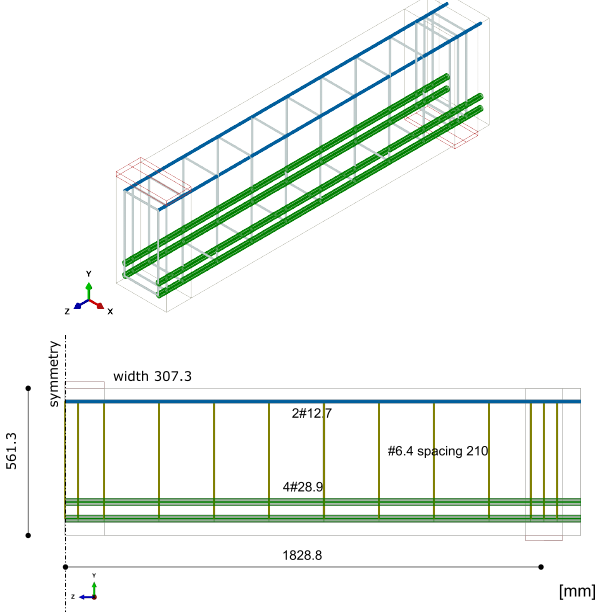
Figure 26. A-1 beam—dimensions and boundary conditions assumed in the analysis.